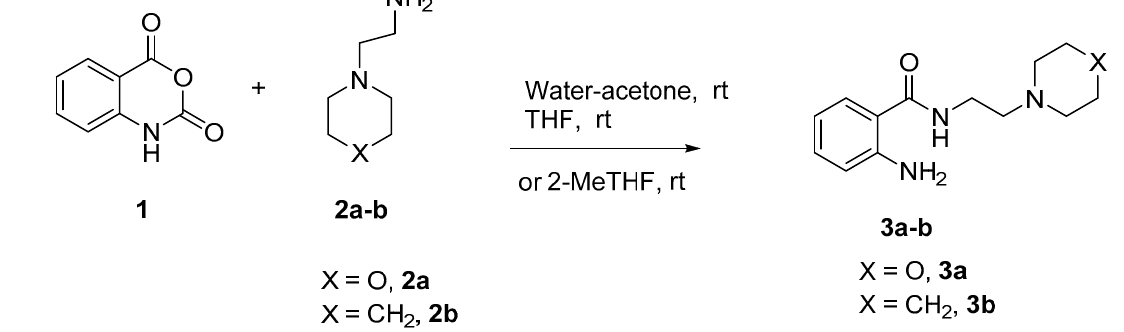
Table 1. Reaction of isatoic anhydride using different solvents to afford the product 3a.